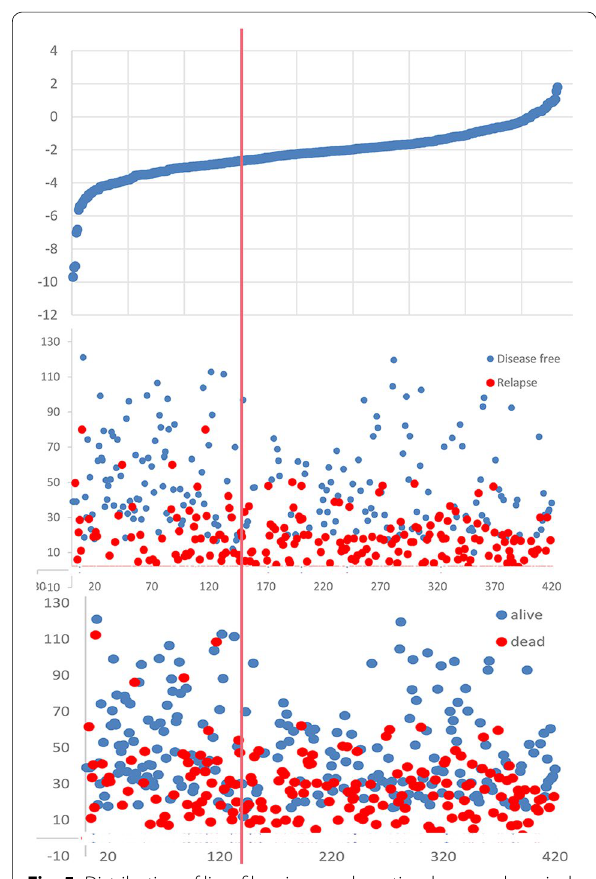
Fig. 5 Distribution of liver fibrosis score, hepatic relapse and survival statuses in validation cohort. Higher liver fibrosis score remained a powerful and independent prognostic factor for hepatic relapse and